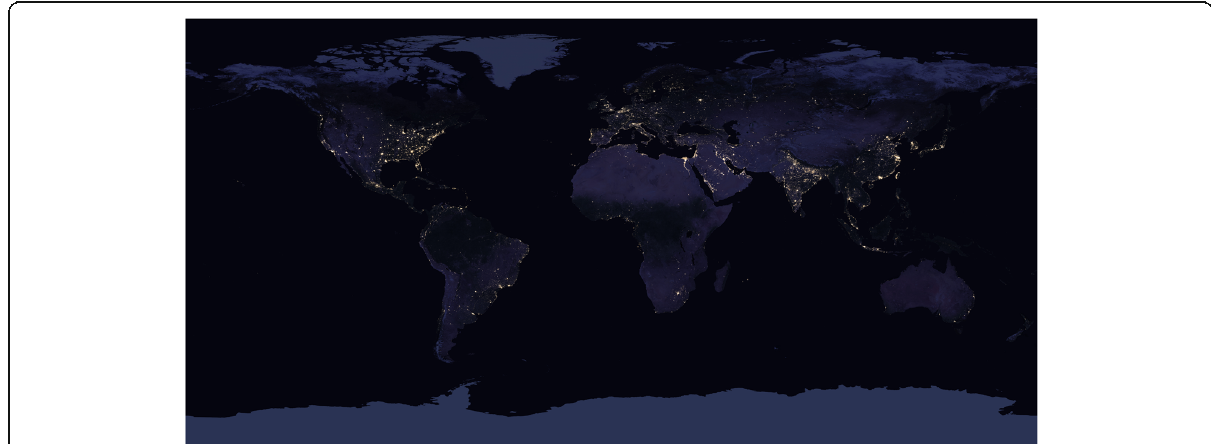
Fig. 6 A VIIRS 2016 Black Marble 3 km composite image of global night lights, created from the NASA VIIRS DNB (Day-Night Band) algorithm (resolution reduced from